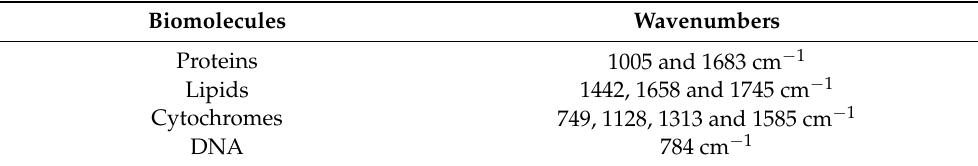
Table 1. List of biomolecular components and their corresponding wavenumbers observed in